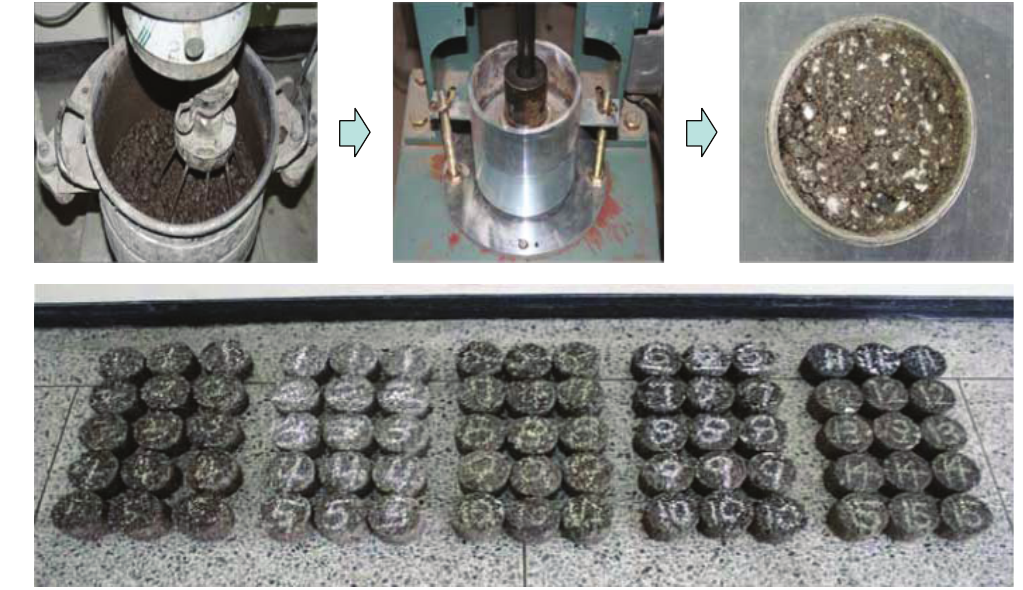
Figure 2: Fabrication process and final manufactured test specimen.